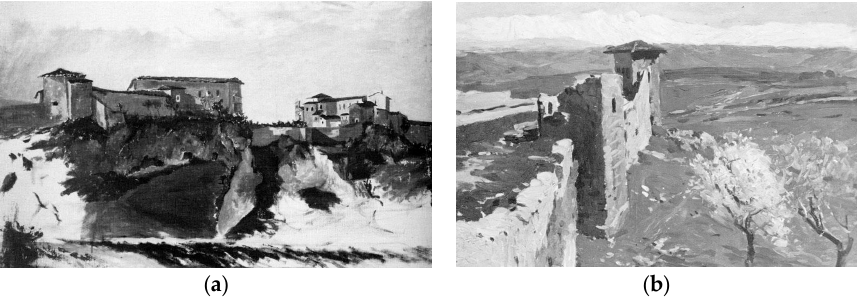
Figure 2. Paintings by D. Cifani: ( a ) View of the former hospital (1919); ( b ) View of the ancient walls (1930).